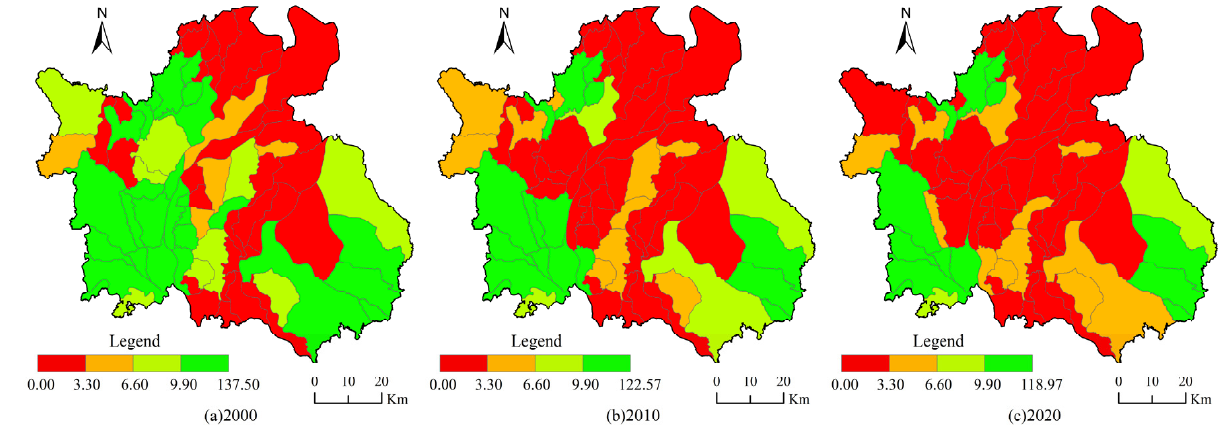
Figure 3. Spatial evolution of scale resilience of Nanchang City based on water network group.